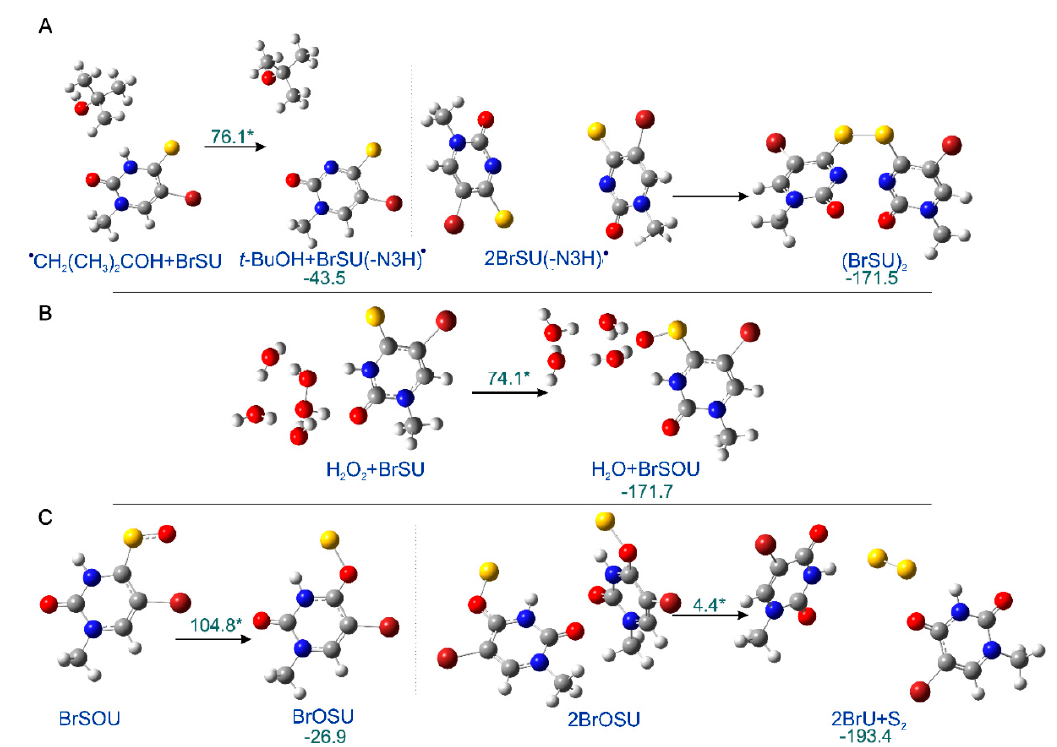
Figure 2. The radiolysis products. ( A ) (BrSU) 2 , ( B ) BrSOU, and ( C ) BrU formation, as suggested by calculations. The optimized reactants in ball and stick representation are shown along with their kinetic barriers (marked with asterisks) and thermodynamic stimulus (kJ/mol). All the reactions shown correspondence to the most favorable pathways, as obtained by the IRC procedure. The transition states structures can be found in Supplementary Materials (Figure S5).